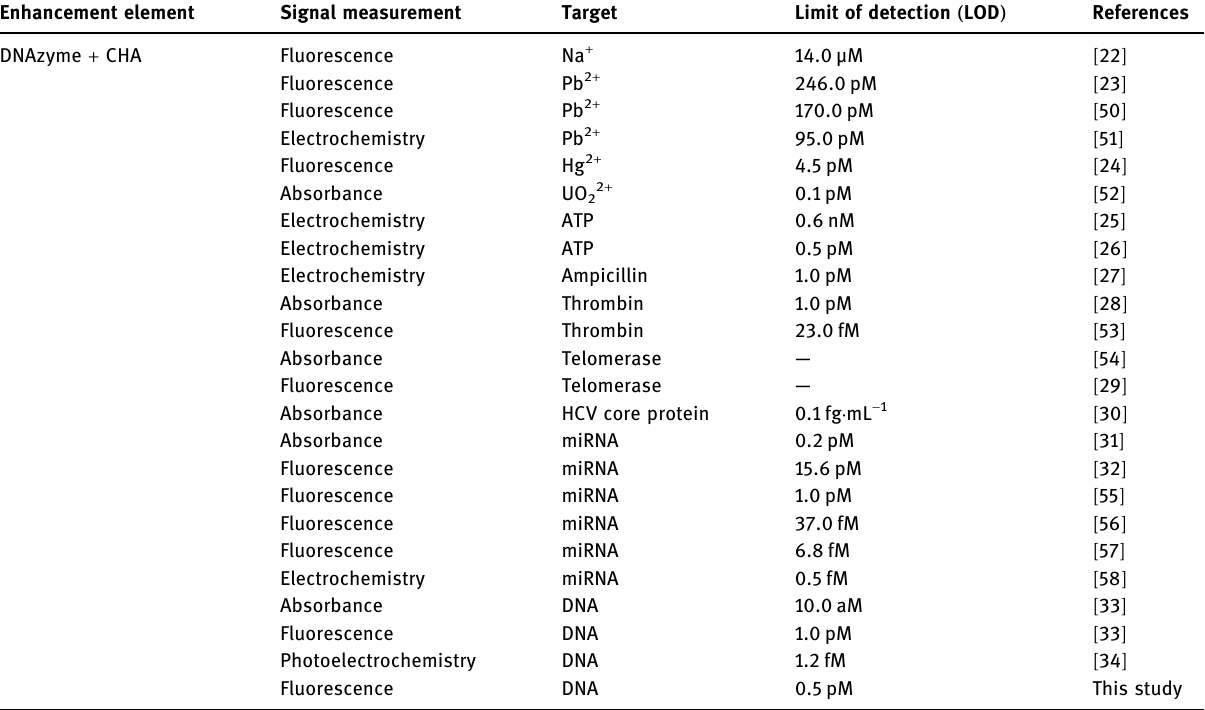
Table 1: A comparison between the present method and other schemes via the coupling use of DNAzyme and CHA Enhancement